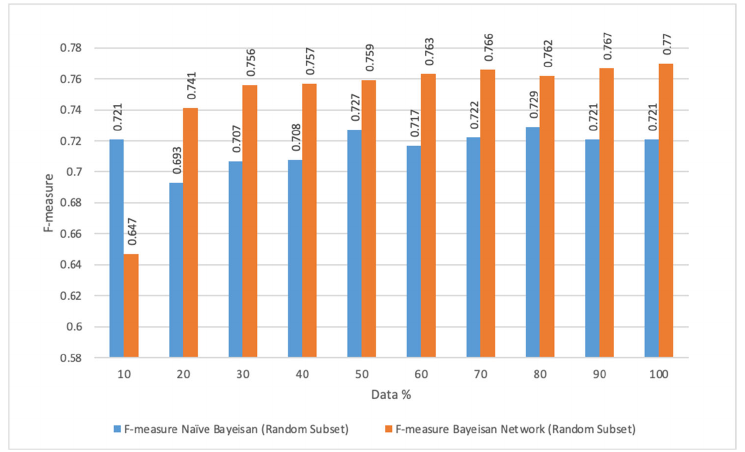
Figure 8. Comparative F ‐ measures for Naïve Bayesian and Bayesian Network with a random subset.